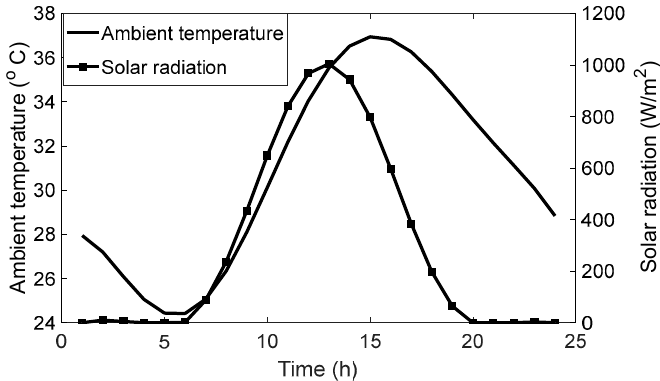
Figure 5. Solar radiation and ambient temperature fitted curves.